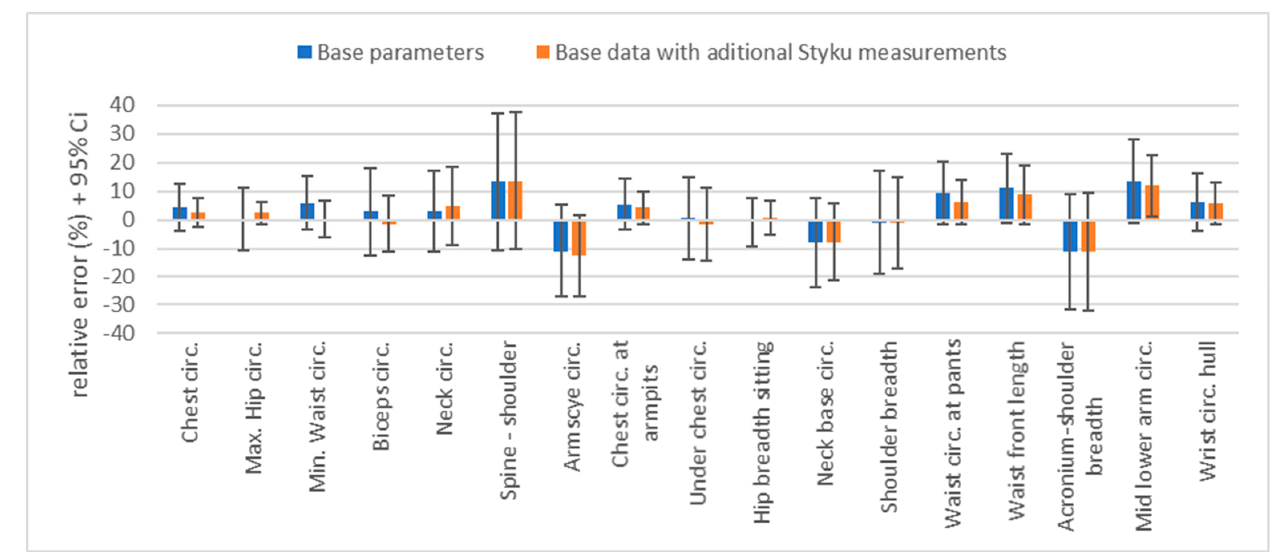
Figure 4. Relative error and 95% confidence interval for both shape model prediction methods.